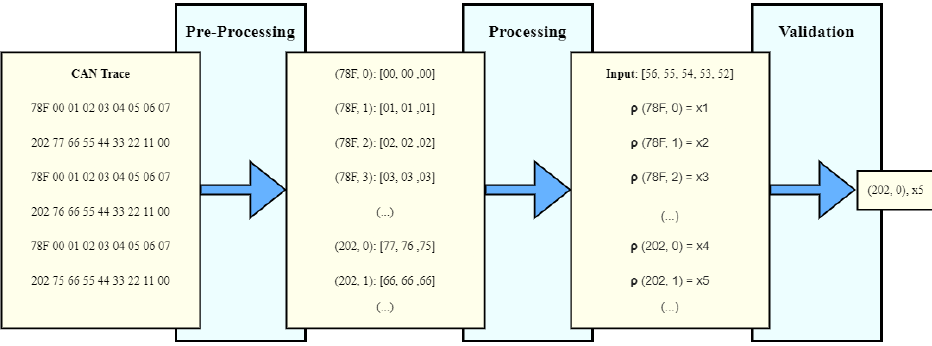
Figure 3. Representation of the proposed algorithm for CAN parameters’ identification.